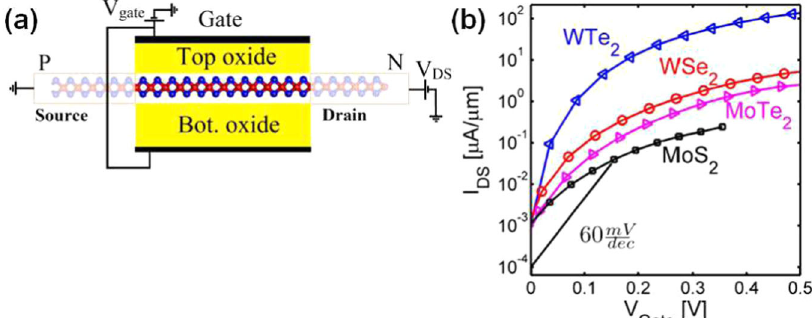
Fig. 12 Simulation Report of Nanoscale 2D TMD-TFET. a Schematics of monolayer-TMD based TFETs, and b Plots of Transfer characteristics of monolayer 2H- VIB TMDs adapted with permission from 91 . Copyright (2015) IEEE.